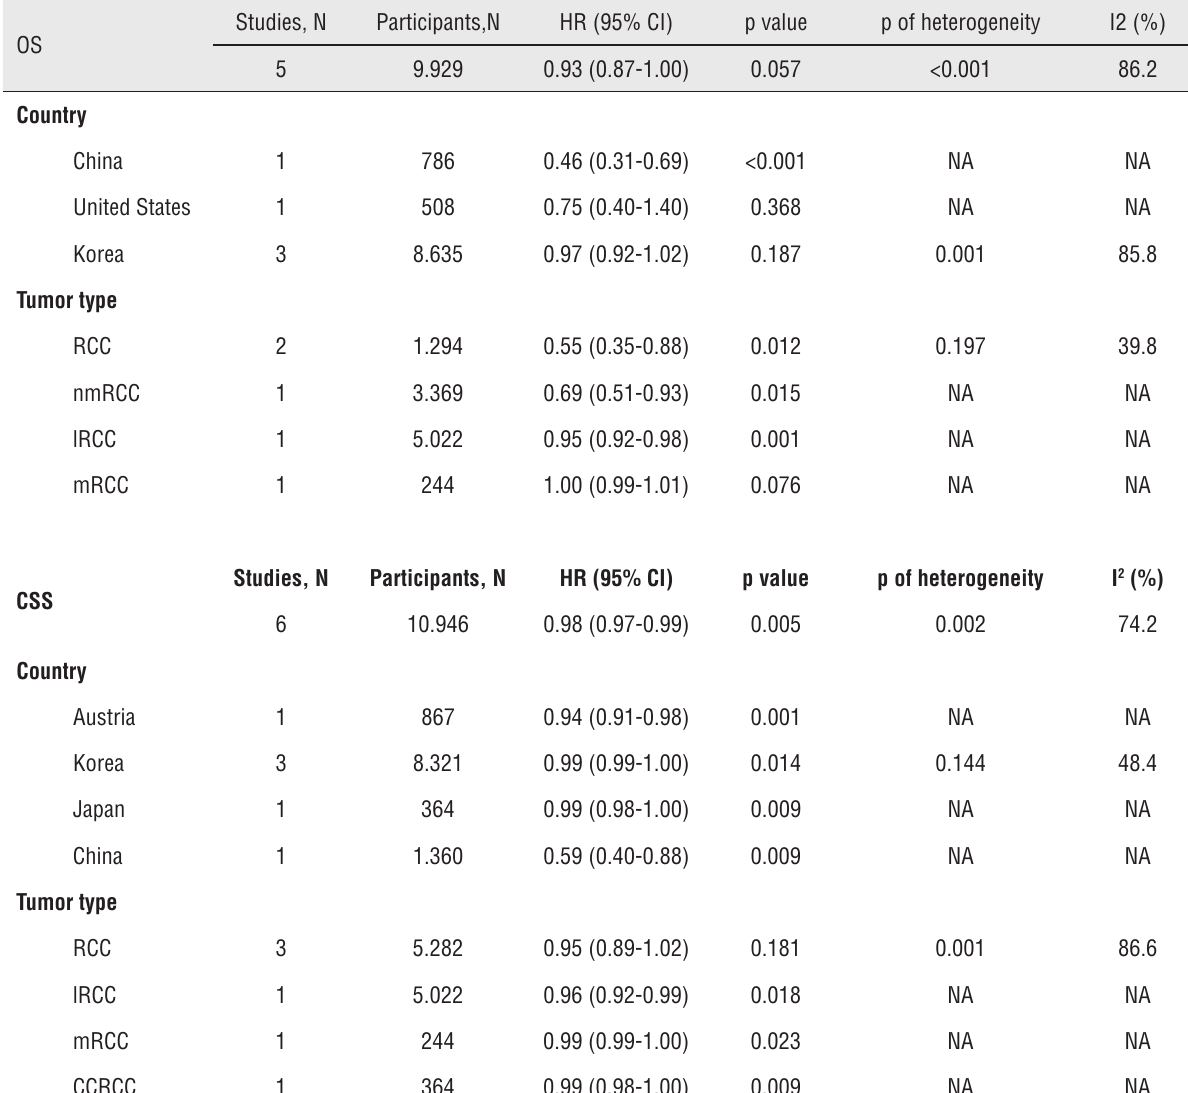
Table 2 - Results of subgroup